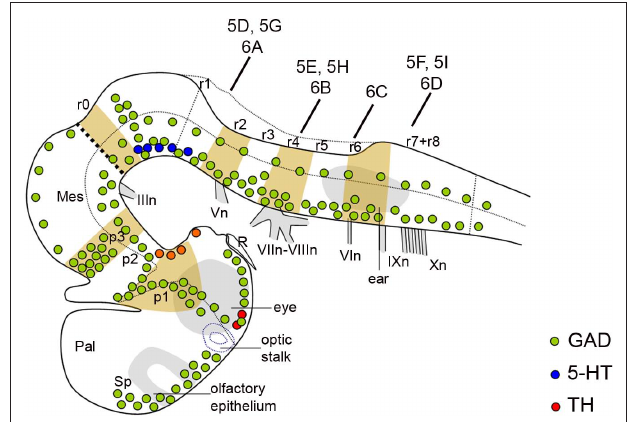
Figure 2 | Schematic representation of the embryonic brain at stage 26 showing the distribution of gAD-ir (green dots), 5-HT-ir (dark blue dots), and TH-ir (red dots) cells and the relation to transverse segments. The dotted line indicates the alar–basal boundary. The vertical bars indicate the approximate levels of sections of Figures 5 and 6. For abbreviations, see